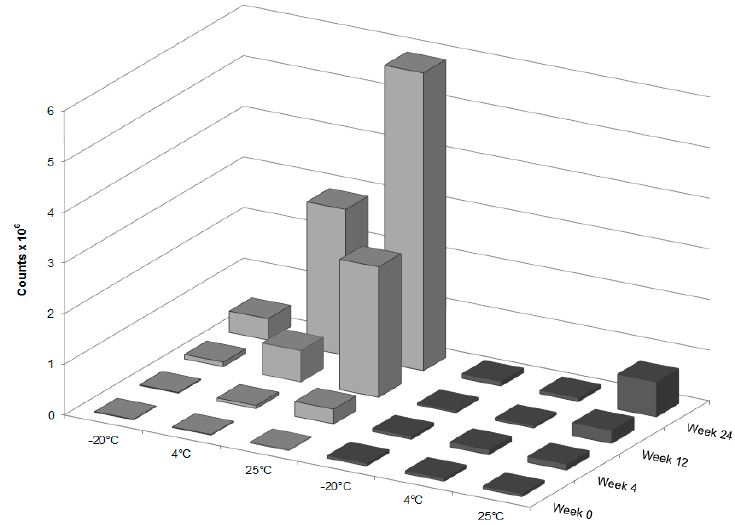
Figure 8. Peak height for the dimer ion located at 819.3 m / z from the composite mass spectra for the liquid (light gray) and lyophilized (dark gray) GT3 NE samples.